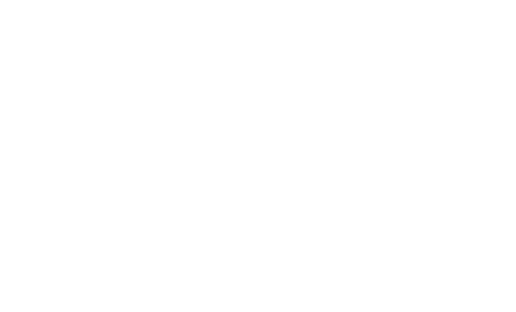
Table 1. The maximum, minimum, and average electric